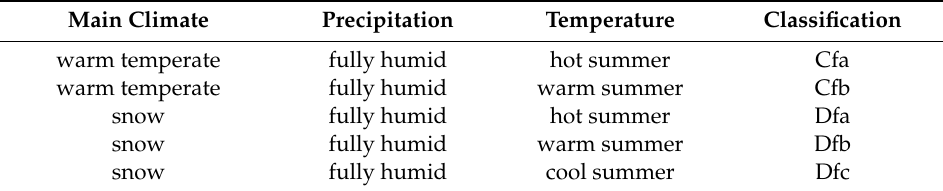
Figure 4. Humid climates of Europe and North America (“Cf” and “Df”) according to the Köppen–Geiger classification and depicting the locations of the selected cold attic designs according to their original studies (roughly redrawn from [36]). Table 1. Köppen–Geiger climate classification (according to [36]).